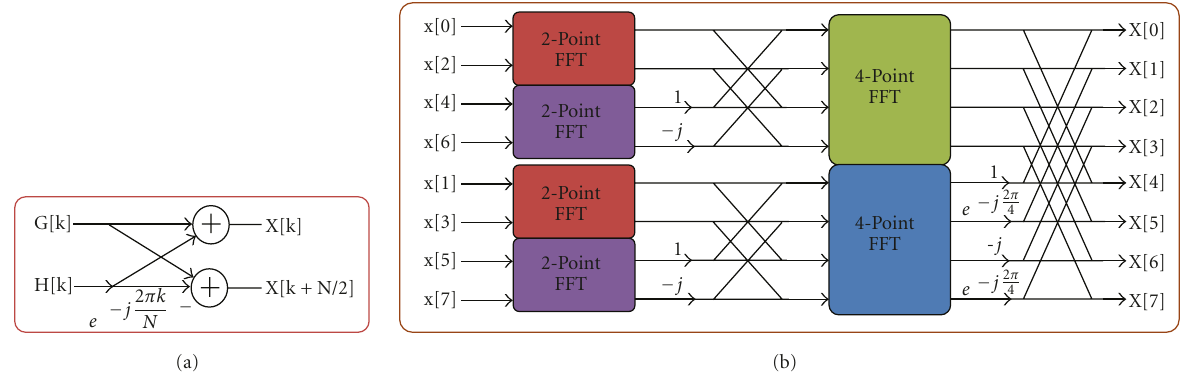
Figure 9: (a) 2-point FFT and (b) The decomposition of a DIT 8-point radix-2 FFT.